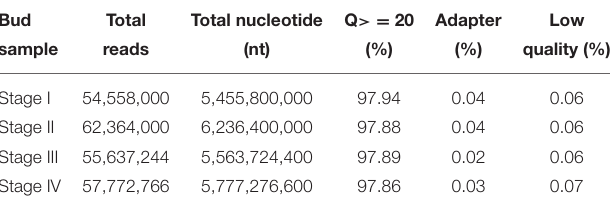
TABLE 1 | RNA Sequencing result.